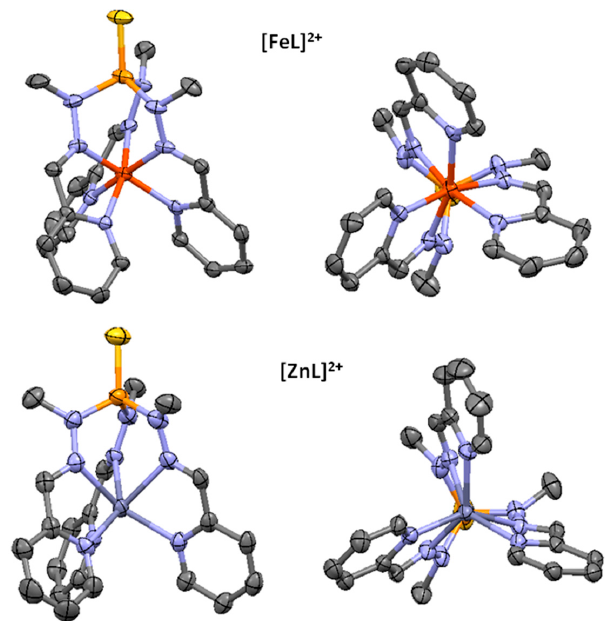
Figure 1. ( left ) Side views and ( right ) projections along M–P–S of molecular structures of ( top ) [FeL] (BF 4 ) 2 and ( bottom ) [ZnL] (ClO 4 ) 2 . Ellipsoids of 50% probability; only the dicationic complexes are shown; counterions, solvent molecules, and hydrogen atoms have been omitted for clarity. Dark grey: carbon, blue: nitrogen, yellow: sulfur, light orange: phosphorous, dark orange: iron, light grey: zinc atoms. Table 1. Crystallographic data.